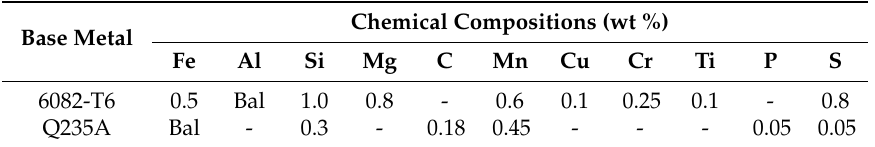
Table 1. Chemical composition of base